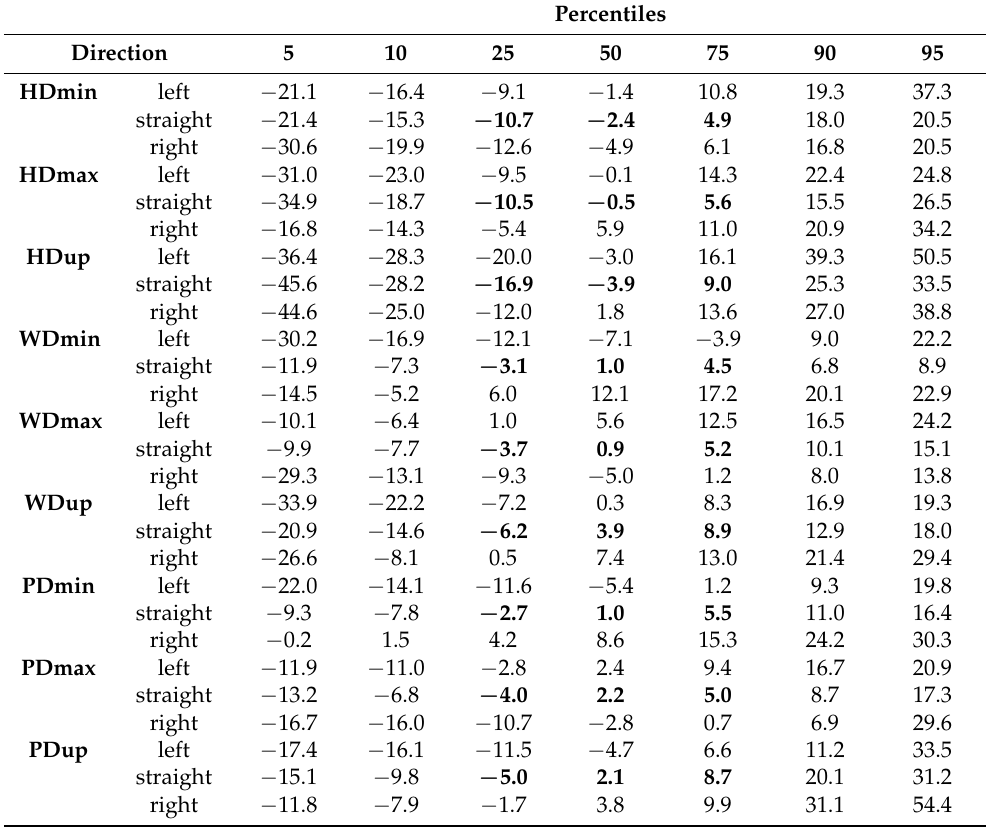
Table 1. Percentiles for 6 movement symmetry measures (in mm) calculated from vertical displace- ment of head, withers and sacrum for in-hand, straight-line trot and left and right lunge exercise for N = 30 reining Quarter Horses. Highlighted are straight-line percentiles (bold) and median (50th percentile, bold) values.